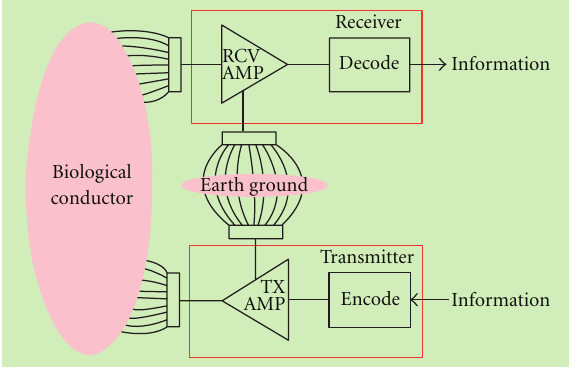
Figure 2: Electric field stream line model of PAN [1,